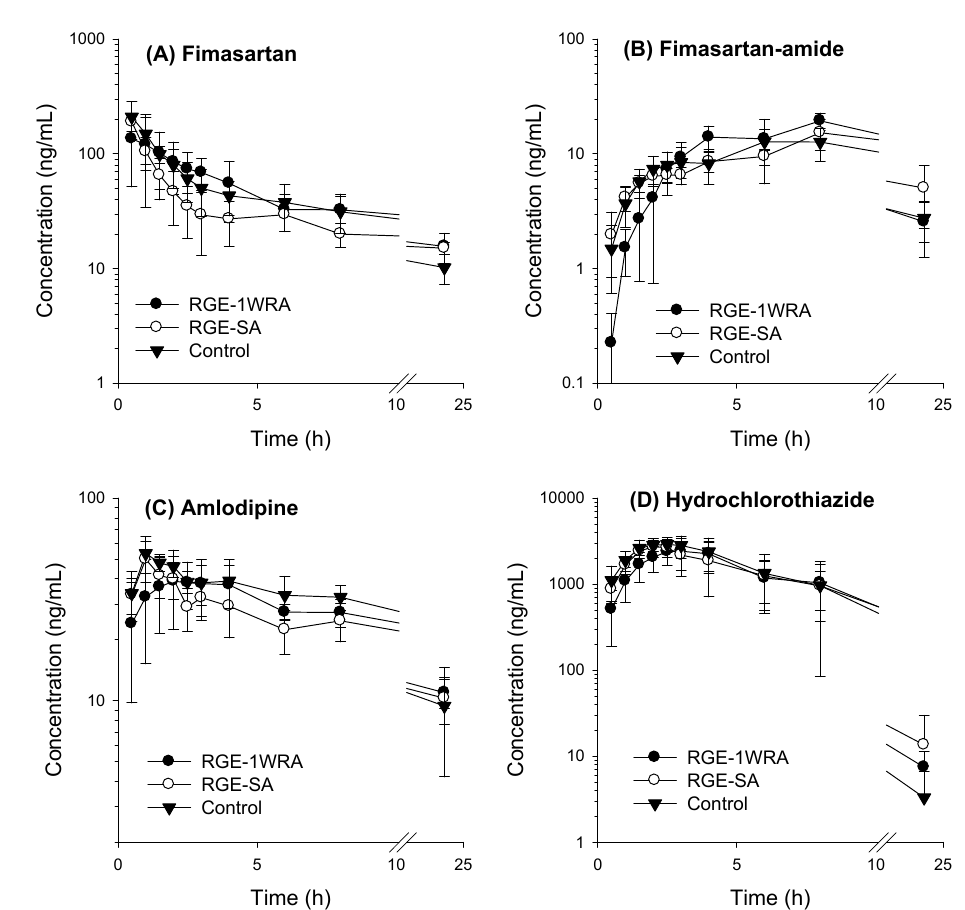
Data are represented as mean ± standard deviation from five rats; NC: not calculated; C max : maximum plasma concentration; AUC last or AUC inf : area under the plasma concentration–time curve from zero to last time or infinity; T max , time to reach C max ; T 1/2 , elimination half-life; MRT, mean residence time. The p -value was calculated using the non-parametric Kruskal–Wallis test.